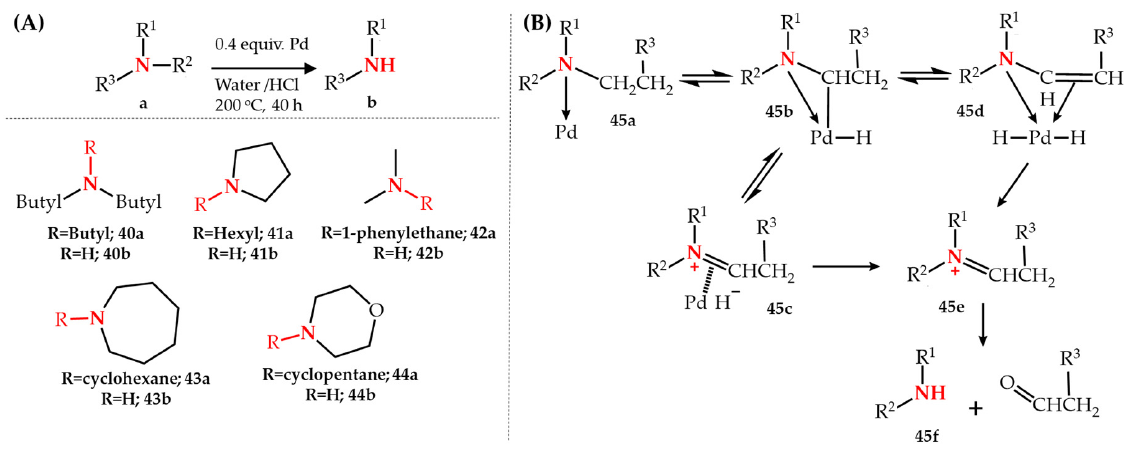
Figure 5. ( A ) Pd ‐ catalyzed N ‐ dealkylation of aliphatic and cyclic tertiary amines and ( B ) plausible mechanistic pathways.